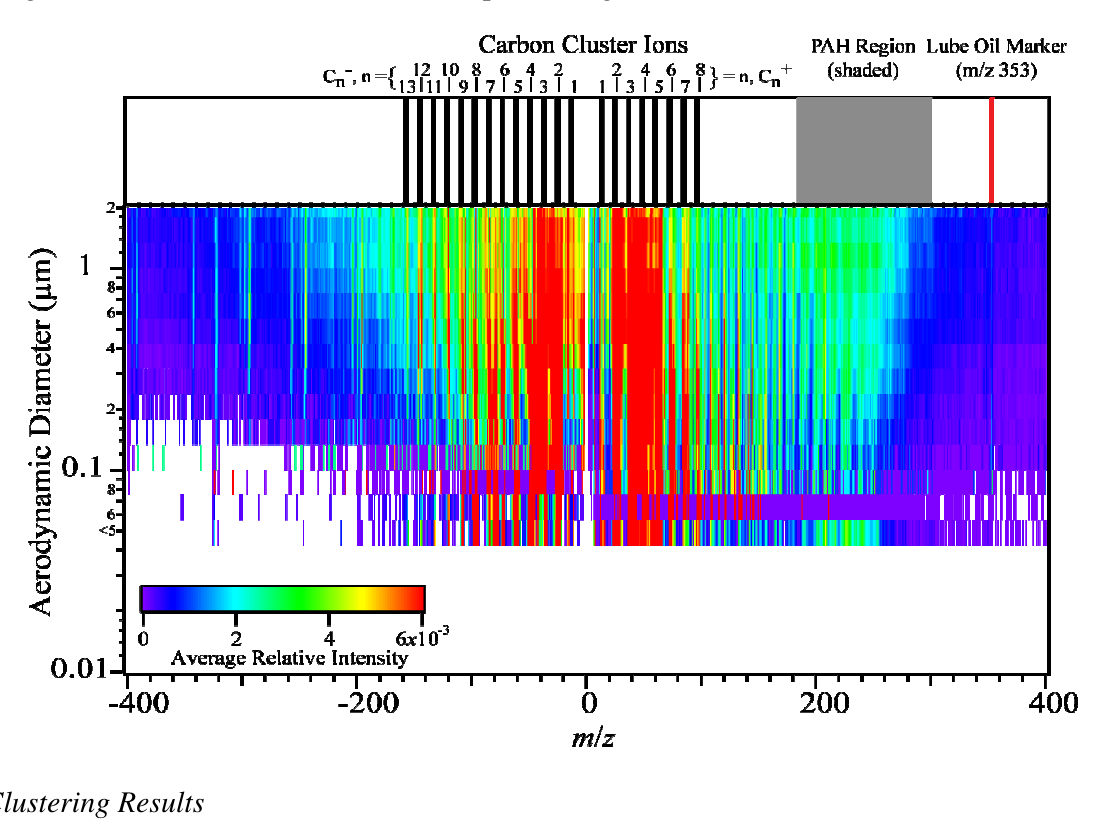
Figure 5. Average single particle mass spectra as a function of aerodynamic size for E85. The average relative intensity of the ions is indicated on the color-scale. Specific ions or regions of interest are indicated at the top of the